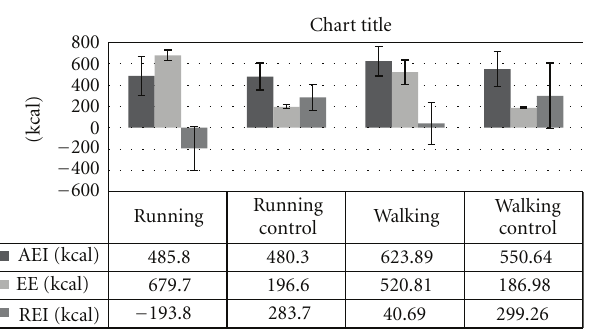
Figure 5: Absolute energy intake (AEI), relative energy intake (REI), and energy expenditure (EE) for exercise and rest in runners and